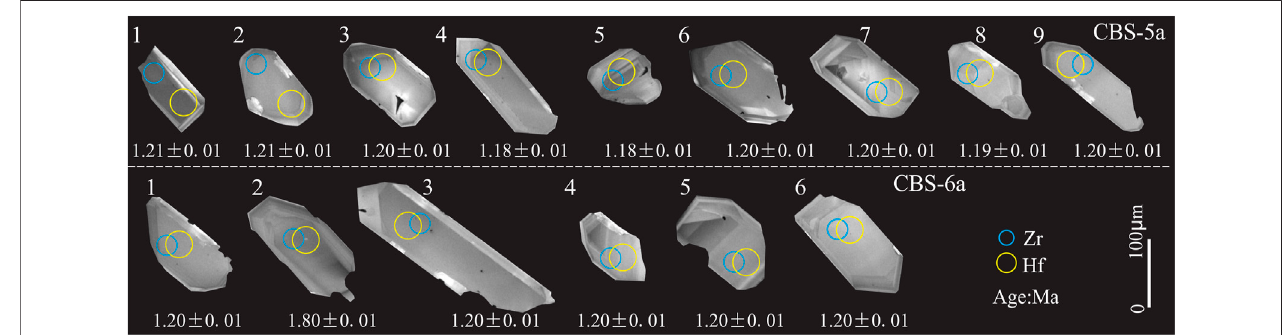
FIGURE 4 | Cathodoluminescence (CL) images of zircons from the trachybasalt dike.